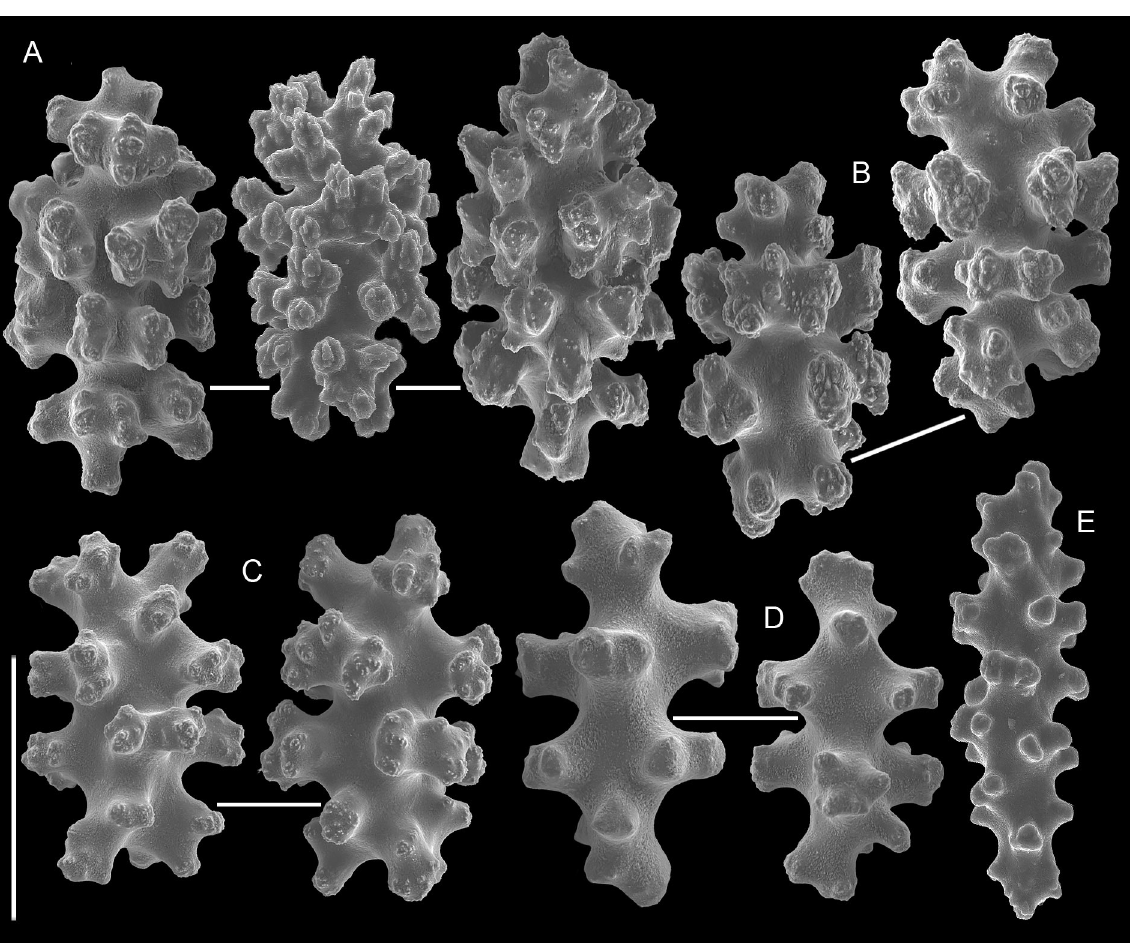
Fig. 13. Calcigorgia simushiri sp. nov., paratype (MIMB 20703), sclerites of the coenenchyme. A . Ovals. B . Capstans with unequally developed ends. C . Capstans (8-radiate sclerites) with symmetrically developed end with well calcified processes. D . Capstans (8-radiate sclerites) with less calcified processes. E . Spindles. Scale bar: 0.1